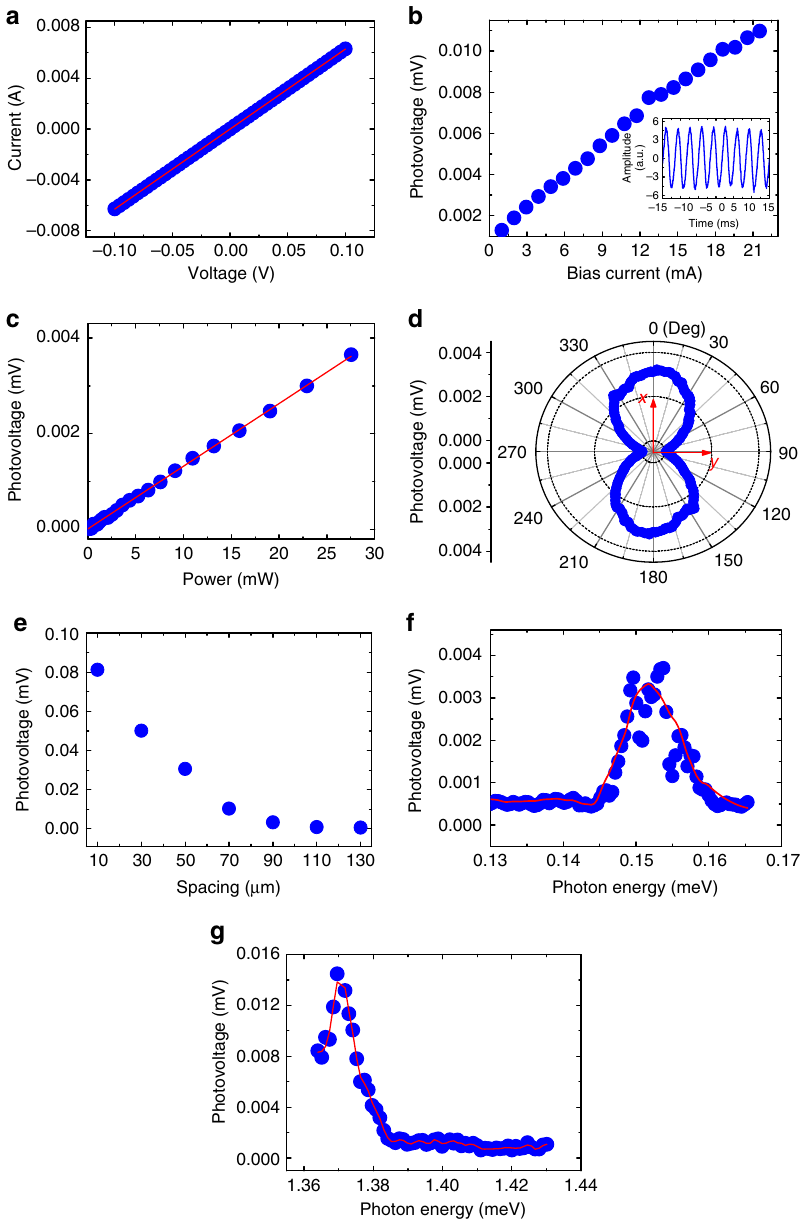
Fig. 4 Characterization of the antenna-assisted subwavelength Au – InSb – Au devices. a Room temperature current – voltage ( I – V ) characteristics of the device with s = 90 µ m. The red line is the linear fi t to the experimental data. b Photovoltage of the same device under 25 mW illumination of a 0.151 meV source at a modulation frequency of 300 Hz, as a function of DC bias current. The inset is a typical photoresponse waveform recorded by an oscilloscope. c Photovoltage of the same device as a function of source output power at 300 Hz under a DC bias of 3.5 mA. The red line is the linear fi t. d Polarization dependence of the photovoltage of the device measured under a DC bias of 3.5 mA and at the source output power of 25 mW. The vertical and horizontal axes are designated as x and y , respectively. e Photovoltages of devices with different values of spacing, measured in the same conditions as for the device with a spacing of 90 µ m. f Photovoltages of the device for incident waves with photon energies from 0.130 to 0.165 meV under a DC bias of 3.5 mA. The red line is a smoothed version of the data for easier viewing. g Photovoltages of the device designed for detecting 1.37 meV (0.332 THz) photons for incident photons from 1.36 to 1.43 meV under a DC bias of 3.5 mA. The red line is a smoothed version of the